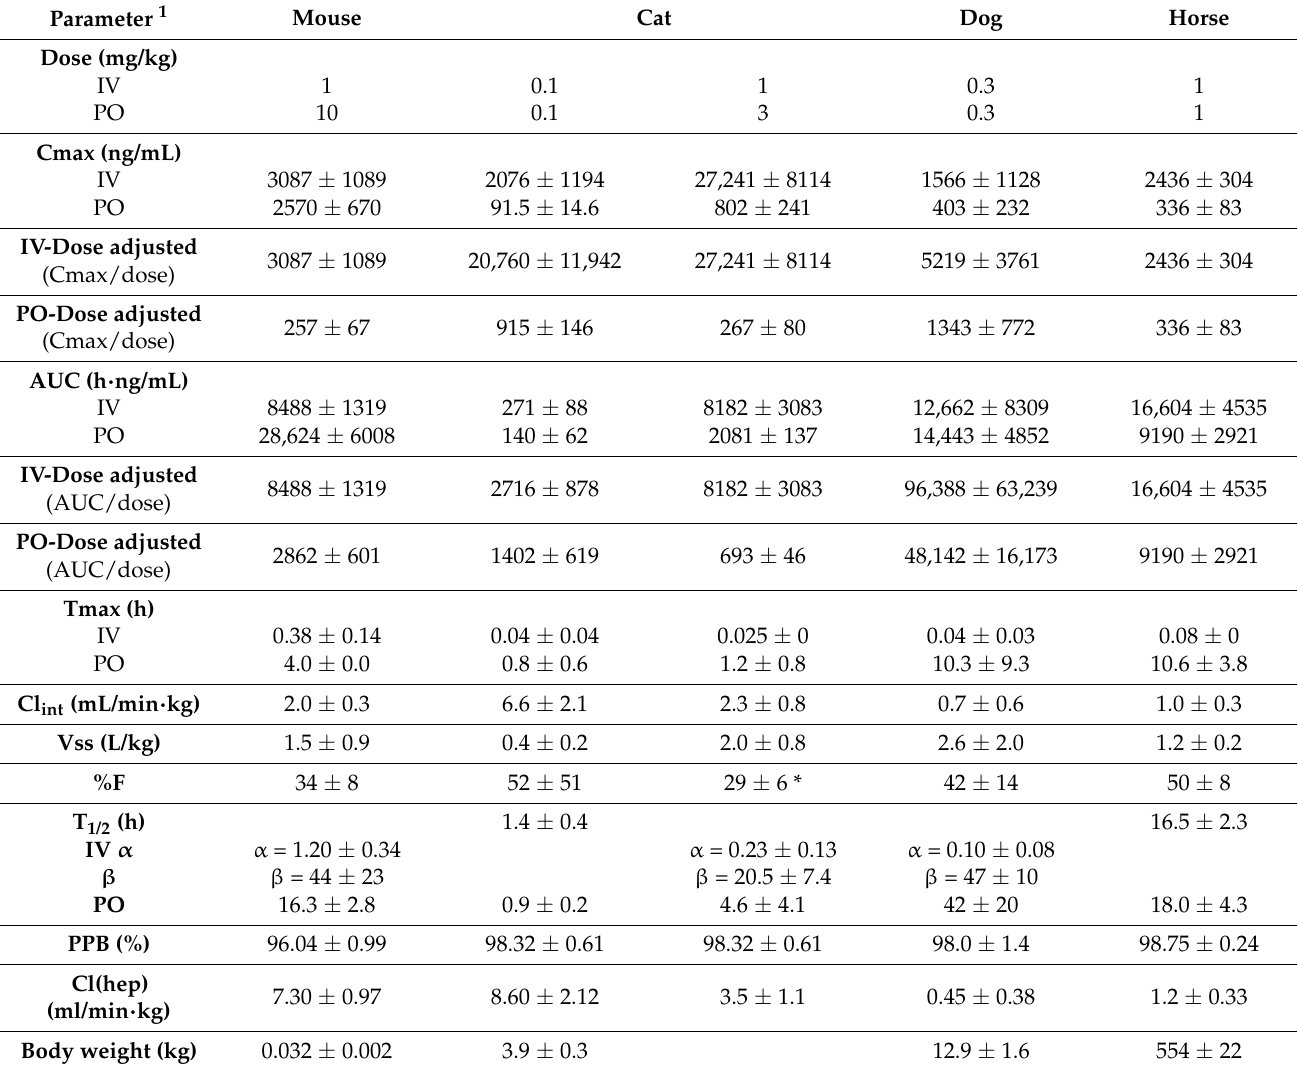
Table 2. Summary of key PK parameters between